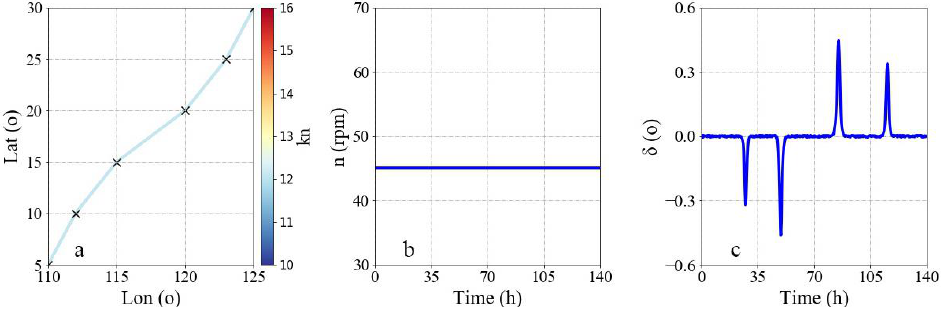
Figure 5. Optimization result of still water scenario. ( a ) Speed distribution, ( b ) rotating speed of propeller command, and ( c ) rudder angle command.